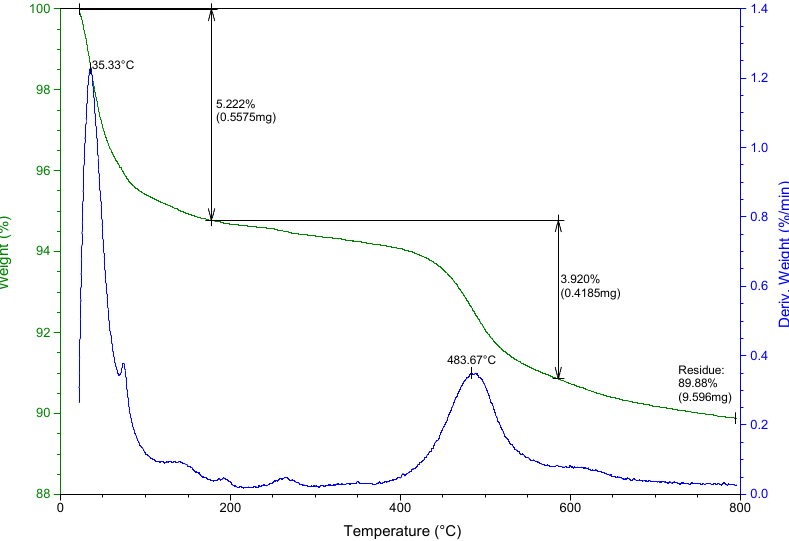
Figure 3. TGA analysis of purified raw bentonite clay.